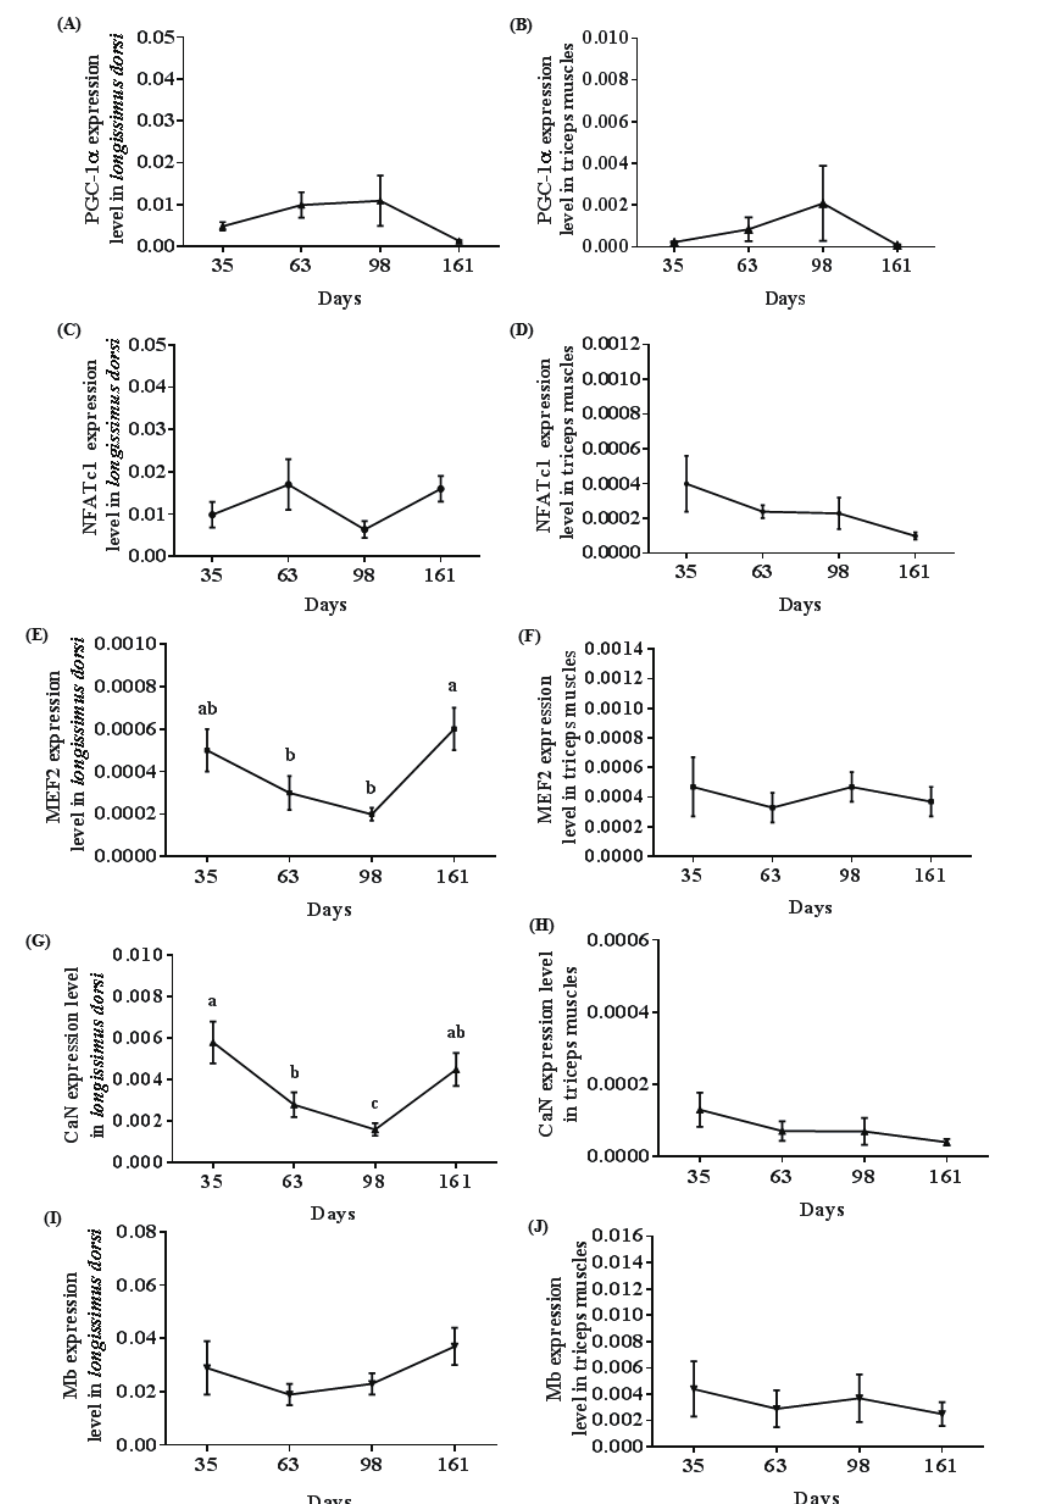
Figure 4. Changes in expression of genes associated with oxidation of porcine skeletal muscle at different stages of growth. (A, B) Peroxisome proliferator-activated receptor γ co- activator-1 α (PGC-1 α ) expression level in longissimus dorsi and triceps muscles, respectively. (C, D) Nuclear factor of activated T cells (NFATc1) expression level in longissimus dorsi and triceps muscles, respectively. (E, F) Myocyte enhancer factor 2 (MEF2) expression level in longissimus dorsi and triceps muscles, respectively. (G, H) Calcineurin (CaN) expression level in longissimus dorsi and triceps muscles, respectively. (I, J) Myoglobin (Mb) expression level in longissimus dorsi and triceps muscles, respectively. Mean with different superscripts demonstrate significant difference among groups (p<0.05), n =